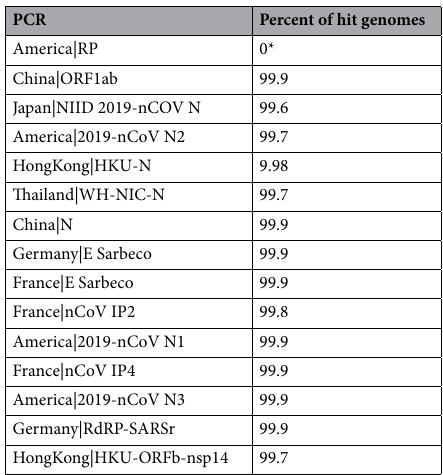
Table 2. Percent of genomes that are hit by the described PCR test, identified by the country and target gene. *Indicates that the primer is designed to separate the any errant samples within the